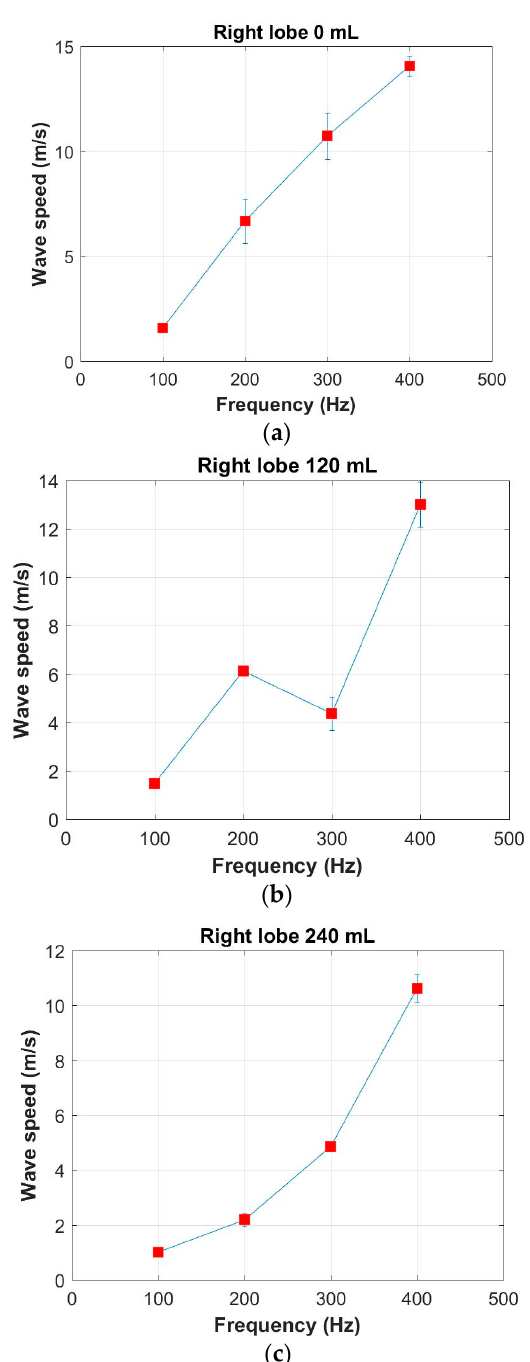
Figure 3. Measurements of surface wave speeds with frequency on the right lobe of the lung. ( a ) 0 mL, ( b ) 120 mL, and ( c ) 240 mL.